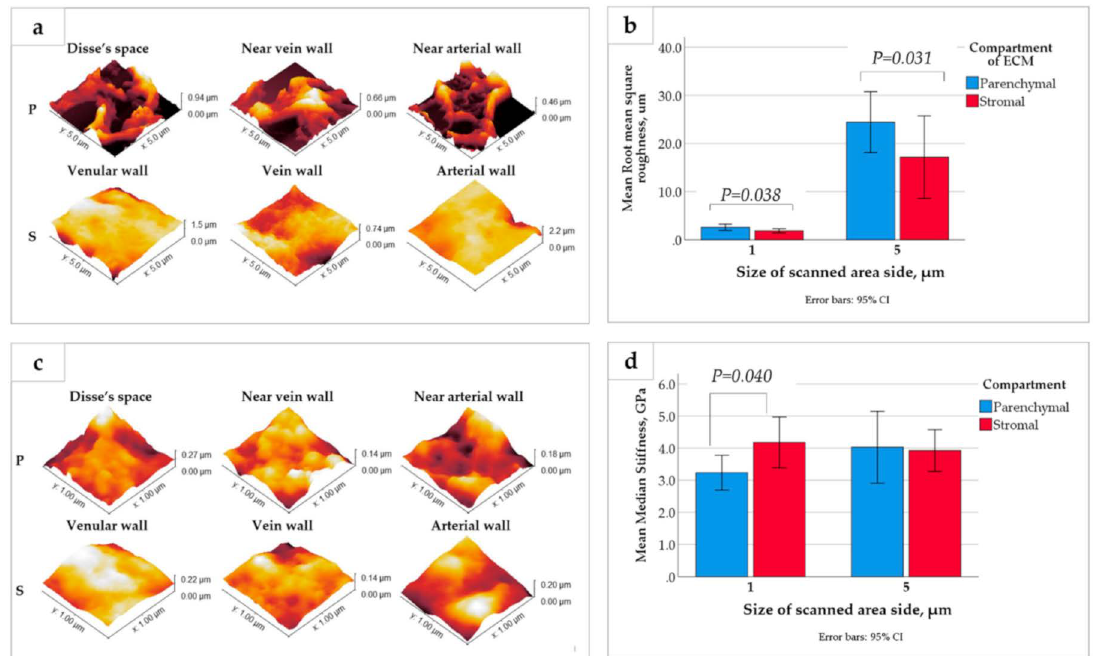
Figure 5. ( a , c ) Topography AFM images of the ( a ) micron scale, 5 × 5 µ m, and the ( c ) submicron, 1 × 1 µ m, areas of the dehydrated CE liver ECMs of parenchymal (P) and stromal (S) origin. ( b , d ) Quantitative analysis of the surface roughness ( b ) and stiffness ( d ) of dehydrated LS-ECM compartments. Notably, the graph in ( b ) shows that the LS-ECM compartments differ by root square roughness at both the micron and submicron scales (explored in 5 × 5 µ m and 1 × 1 µ m images, respectively) with statistical significance. At the same time, as shown in ( d ), the LS-ECM compartments differ by median stiffness with a statistical significance only at the submicron scale (as explored in 1 × 1 µ m